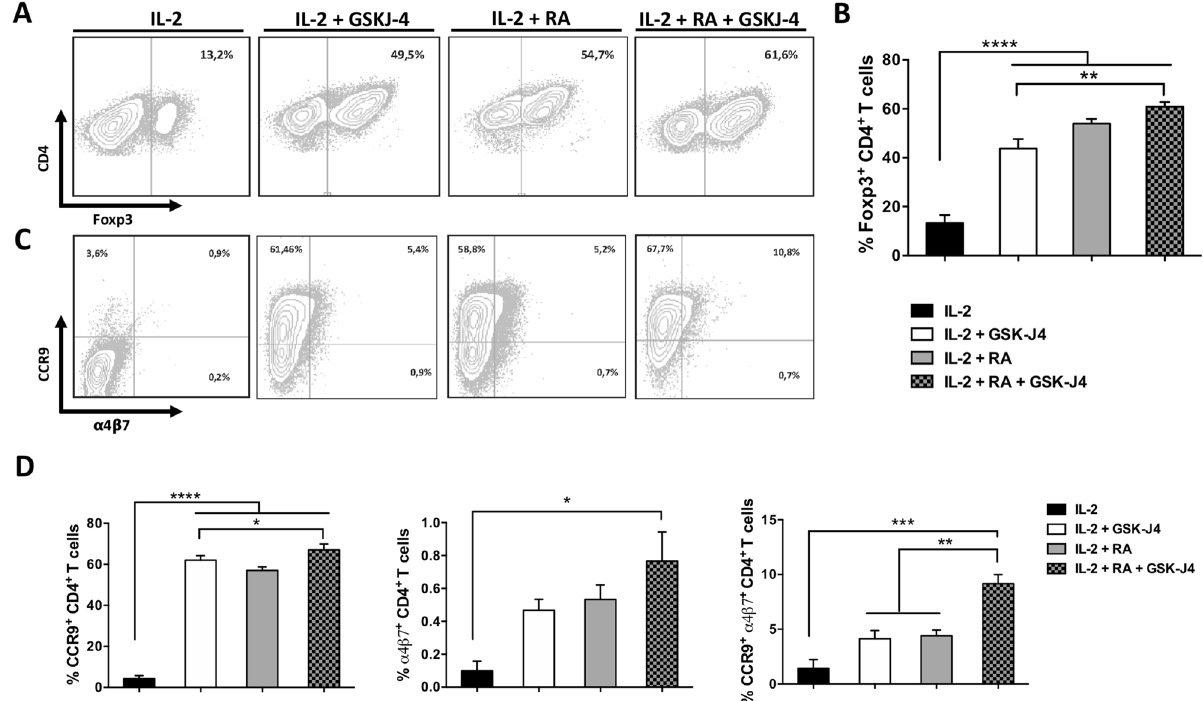
Figure 5. GSK-J4 promotes RA synthesis by DCs. Naïve CD4 + CD25 − Foxp3 − T cells were isolated from Foxp3 GFP mice by cell-sorting and activated with splenic DCs and anti-CD3 Ab under standard Treg polarising conditions (IL-2), or in the presence of either 25 nM GSK-J4, 10 nM RA or both for 4 days. ( A , B ) The extent of iTreg generation was evaluated as the frequency of GFP + (Foxp3 + ) cells in the CD4 + population. ( A ) Representative dot-plots and ( B ) the quantification are shown. ( C , D ) CCR9 and α4β7 expression was evaluated in CD4 + T cells. ( C ) Representative dot-plots and ( D ) the quantification are shown. Data represent mean ± SEM from six independent experiments. * p < 0.05; ** p < 0.01; *** p < 0.001; **** p < 0.0001 as determined by one-way ANOVA followed by Tukey’s post-hoc test ( A – C ). n.s., not significant differences were